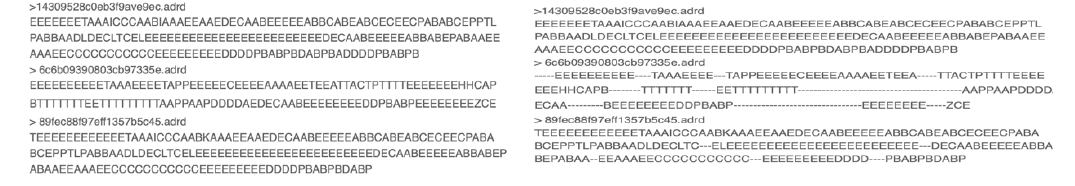
Figure 5. Sample of ADRD family Fasta file and a sample of MSA ADRD family.